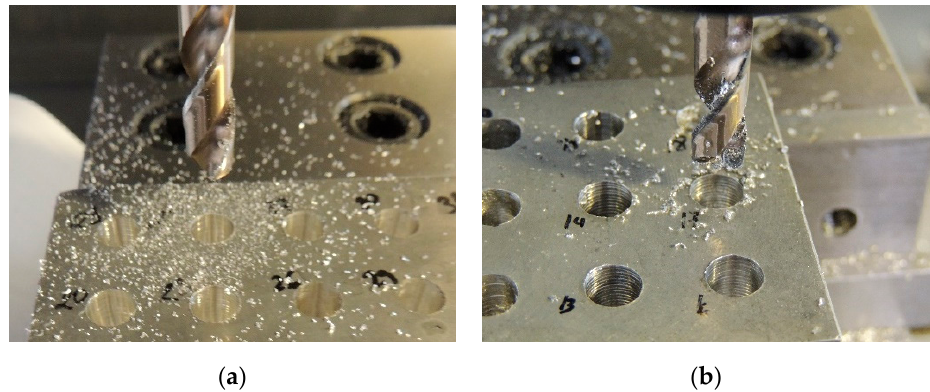
Figure 8. Interaction graph between Lubrication with; point angle, γ * L , coating, C * L , and feed rate, f * L.